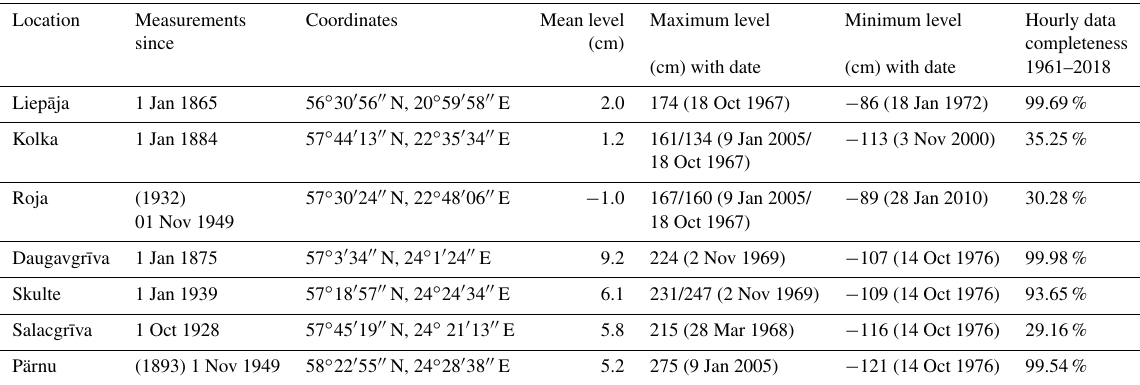
Table 1. The main parameters of the observation locations, basic properties of water level (presented in the BK77 system), and hourly data completeness for 1 January 1961–31 December 2018 in these locations. The maximum water level is extracted from the official data’s current version (Männikus et al., 2020). The data set for Pärnu from 1 January 1961 till 31 December 2018 was provided by the Estonian Weather Service. The slashes indicate different values and their occurrence time in different sources. The year in brackets in the second column indicates the beginning of systematic measurements that have been discontinued.